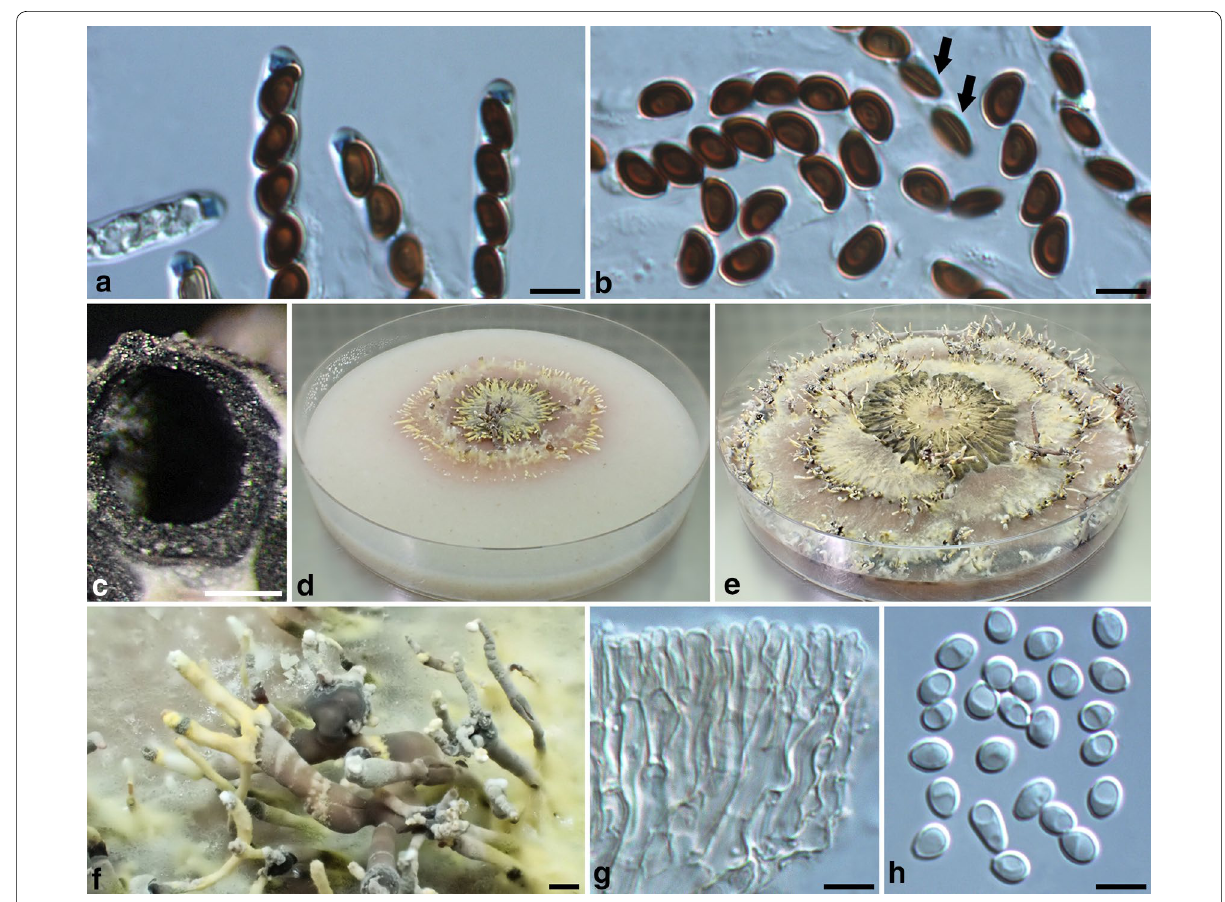
Fig. 4 Xylaria insolita (from the holotype). a Ascal apical rings and ascospores. b Ascospores; the arrows point towards two ascospores showing a germ slit. c Vertical section of a perithecium. d , e Colony on 9‑cm Petri plate containing OA at 2.5 week and 6 week, respectively. f Stromata produced in culture. g Conidiophores. h Conidia. Bars in a , b , g , h